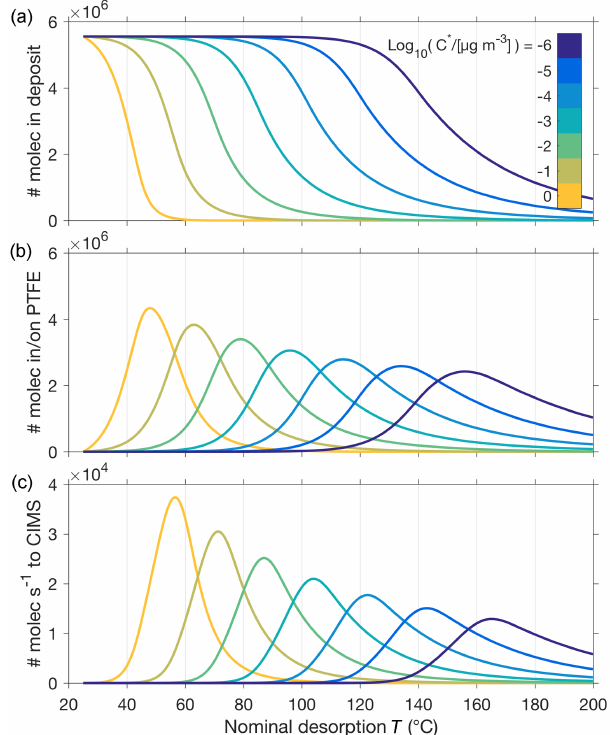
Figure 5. Illustration of model outputs for the simple system of a 150nm aerosol particle composed of only one compound, for seven different values of this compound’s saturation vapor concentration at room temperature (25 ◦ C) C ∗ . (a) shows the number of molecules 0 remaining in the particle as a function of desorption temperature ( T ), which is ramped at a constant rate from 25 to 200 ◦ C and hence proportional to time. (b) shows the number of molecules that have evaporated from the particle and are modeled to stick on surfaces prior to entering the CIMS at the rate shown in (c) .